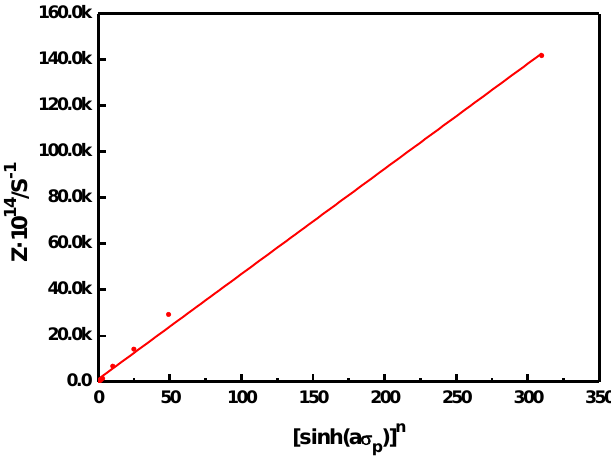
Figure 4. Relationship between Z and ln[sinh( ασ p )].